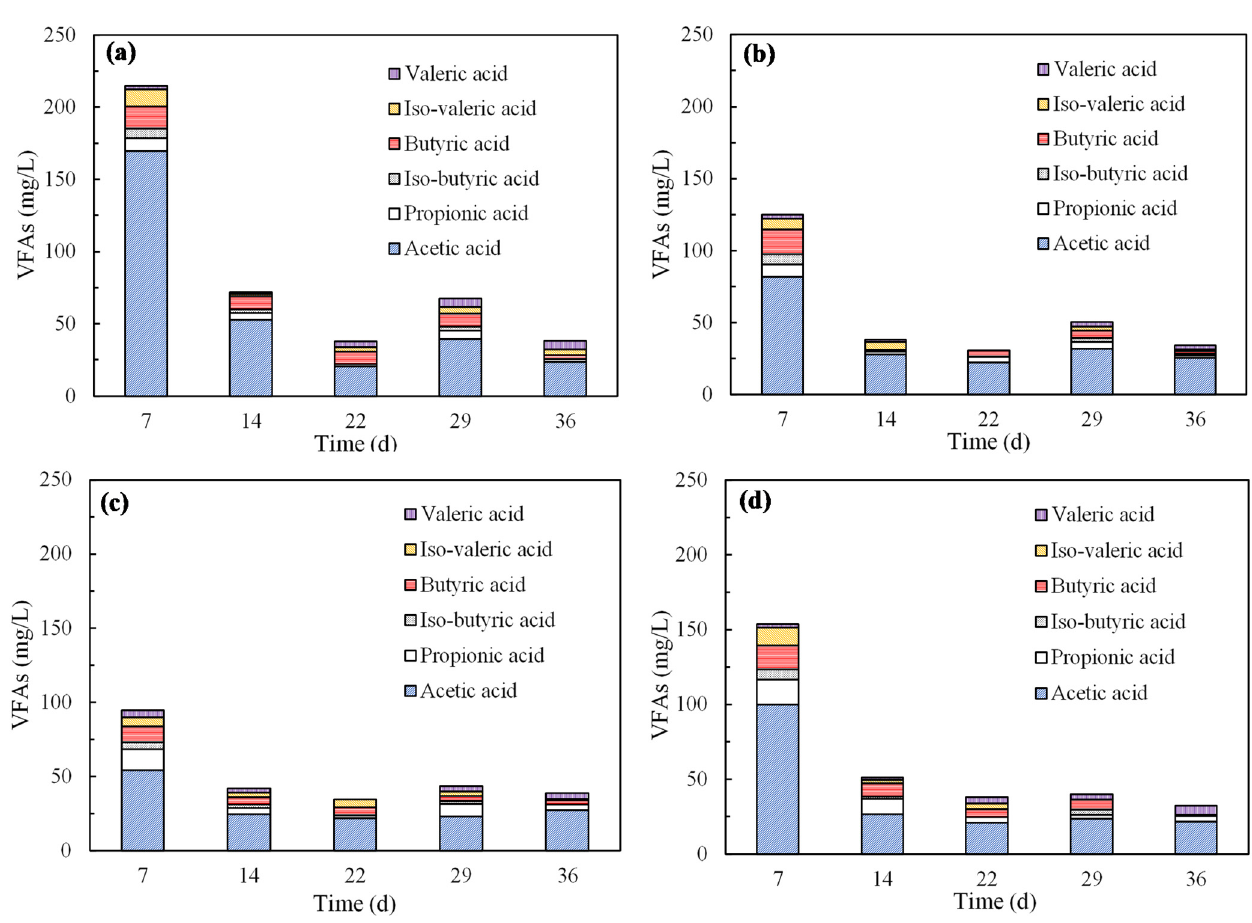
Figure 5. Changes of VFAs during the AD of dairy manure with the addition of 0 g/L ( a ), 1 g/L ( b ), 5 g/L ( c ), and 10 g/L ( d ) of AF-BC.